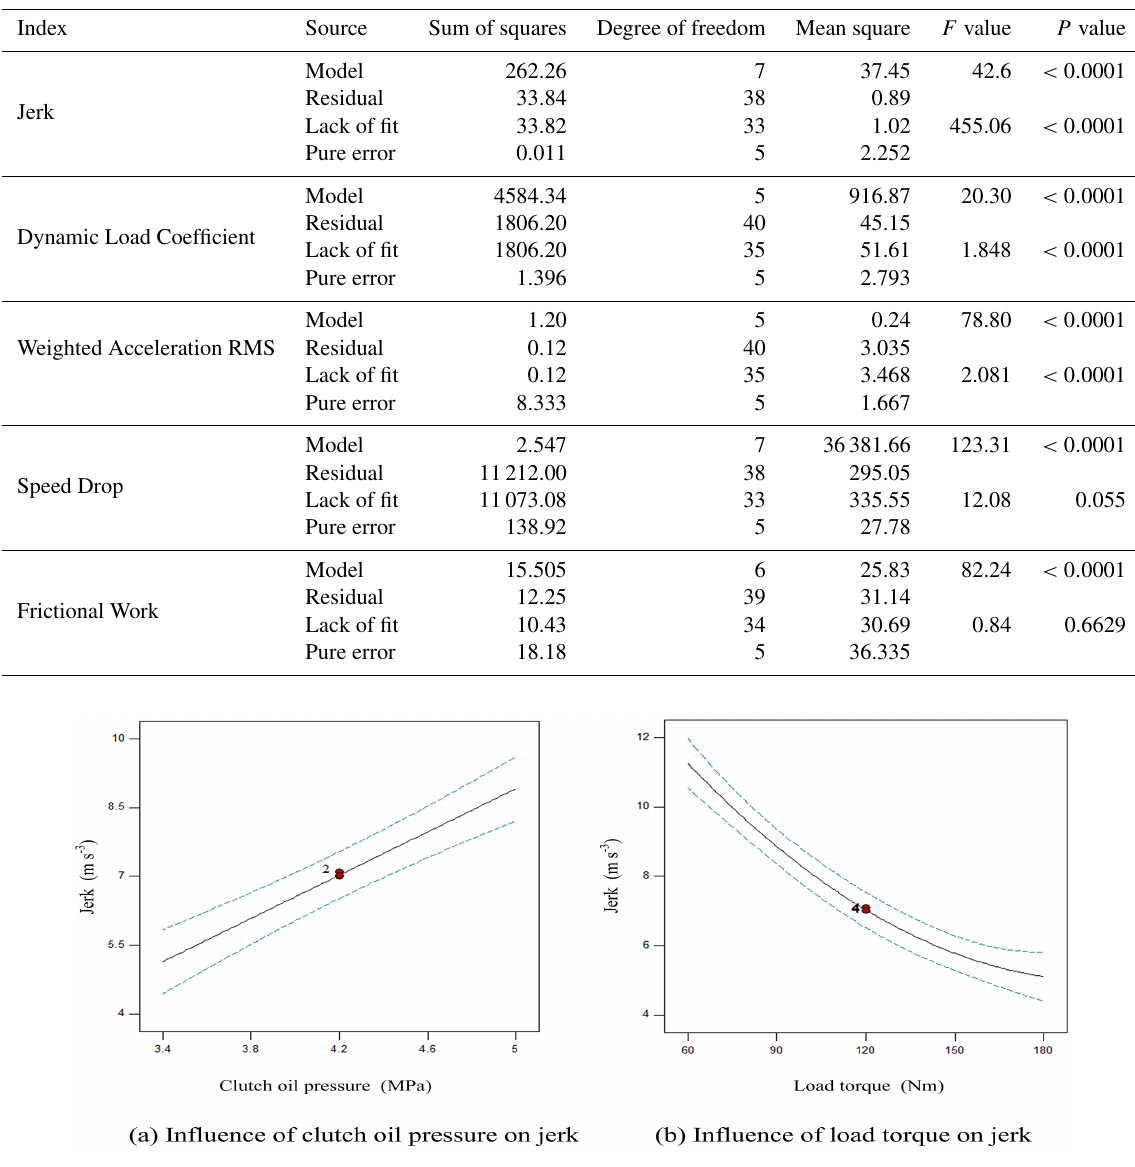
Figure 4. Single influencing factor analysis of